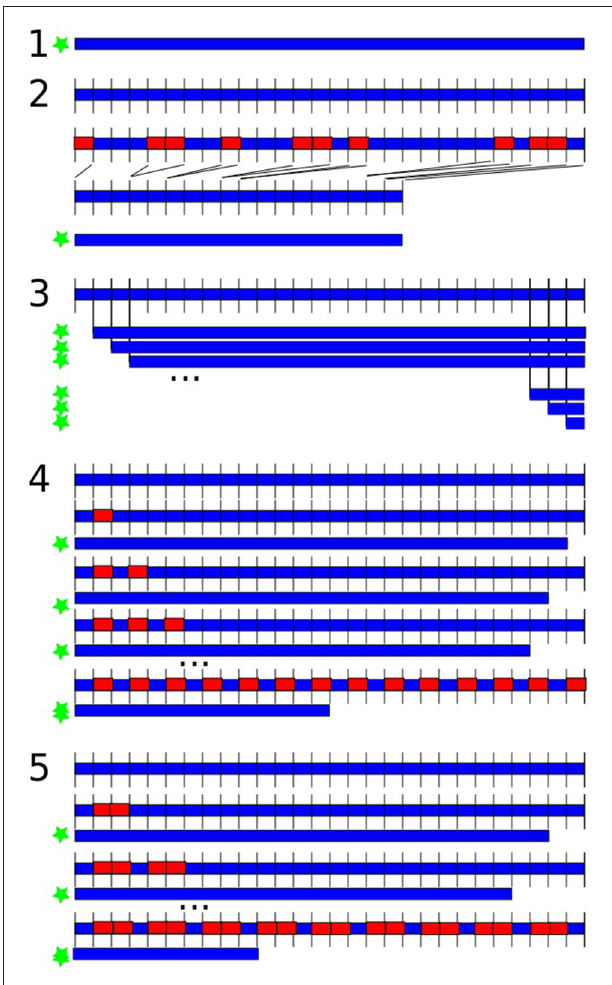
FIGURE 1 | Variations of data length and discontinuity. The blue shape is the data, the red rectangles represent left-out data, the green star indicates which versions were submitted to feature extraction. (1) Analysis over the whole dataset; (2) excluding artifacts in 500 ms segments; (3) repeated feature estimation by shortening 500 ms at the beginning in each repetition; (4) data was segmented into 500 ms segments; repeated feature estimation by increasingly leaving out every second segment; (5) data was segmented into 500 ms segments; repeated feature estimation by increasingly leaving out every second and third